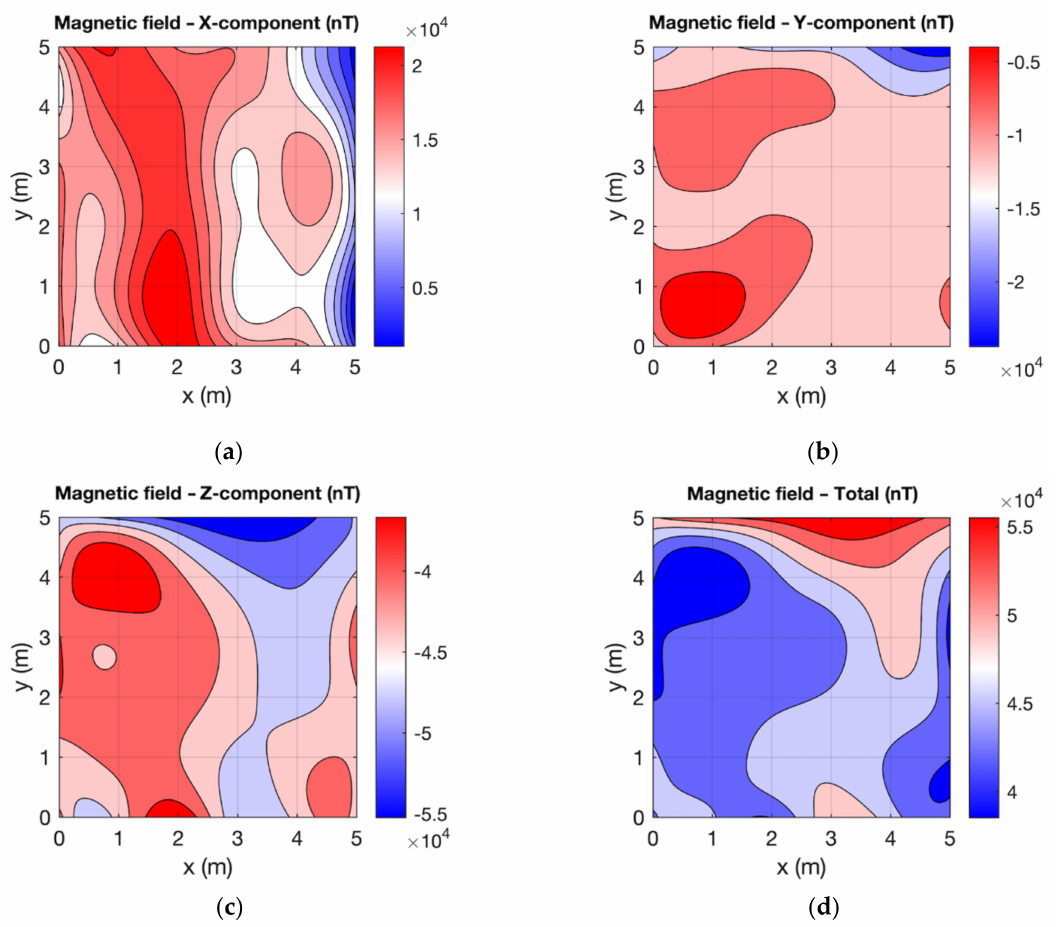
Figure 11. Magnetic field measured by the LEMI magnetometer: ( a ) X-component; ( b ) Y-component; ( c ) Z-component; ( d )